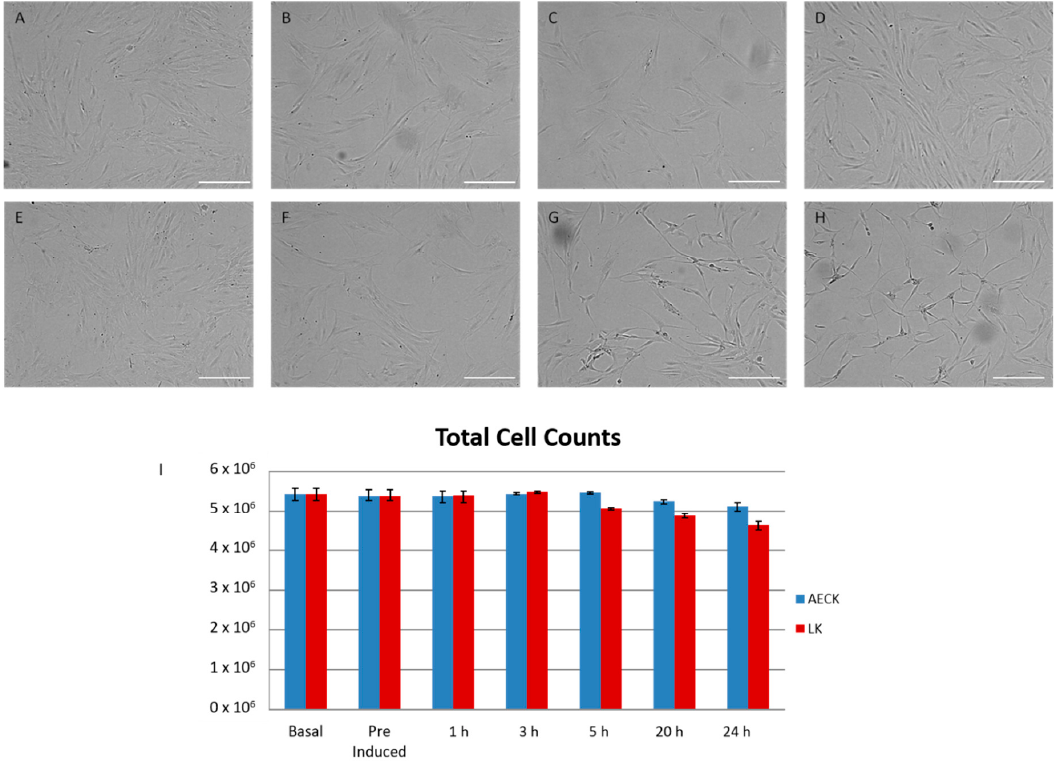
Figure 1. ( A ) Basal human adipose derived stem cells (ADSCs) in vitro culture (non-induced). ( B – D ) human ADSCs induced with 0.5 µ M AECK time points captured at 3, 5 and 24 h respectively. Time course shows minimal structural changes and some cellular contraction producing cells in ( D ) which are marginally more slender than those in ( A ). ( E ) Basal human ADSCs in vitro culture (non-induced). ( F – H ) human ADSCs induced with 0.6 μ M lanthionine ketamine (LK) time points captured at 3, 5, and 24 h respectively. Time course adequately exhibits large structural reconfiguration of ADSCs during differentiation. Cells display bipolar elongation, process, and spindle formation. Microscopy images using a 10x objective lens; scale bar 100 μ m. ( I ) The cell count for the time course of each treatment AECK (blue) and LK (red).